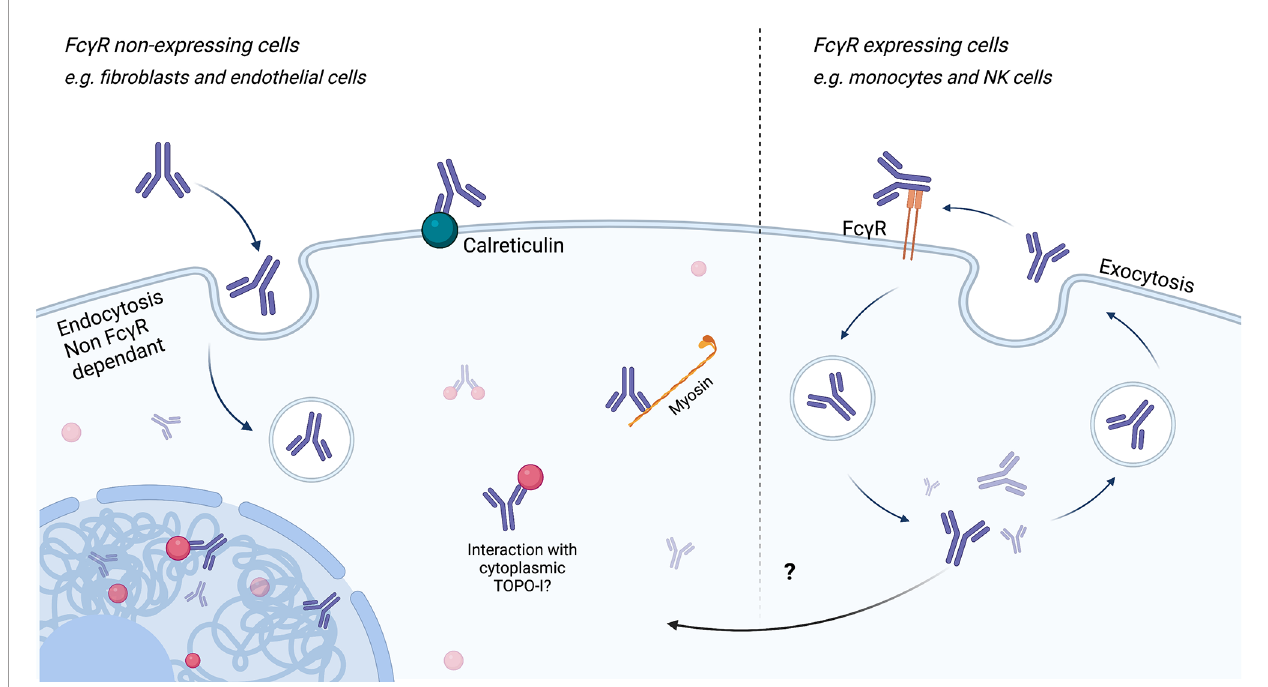
FIGURE 5 | Endocytosis/cell penetration of ANA. Endocytosis of antinuclear antibodies (ANA) can be achieved via Fc g R-dependent or Fc g R-independent (for example, caveolin pathways) mechanisms. Endocytosis independent of Fc g R could be carried out through binding to calreticulin at the membrane and then myosin in the cytoplasm. After reaching the cytoplasm or the nucleus, ANA may interact with its antigen and induce cell modi fi